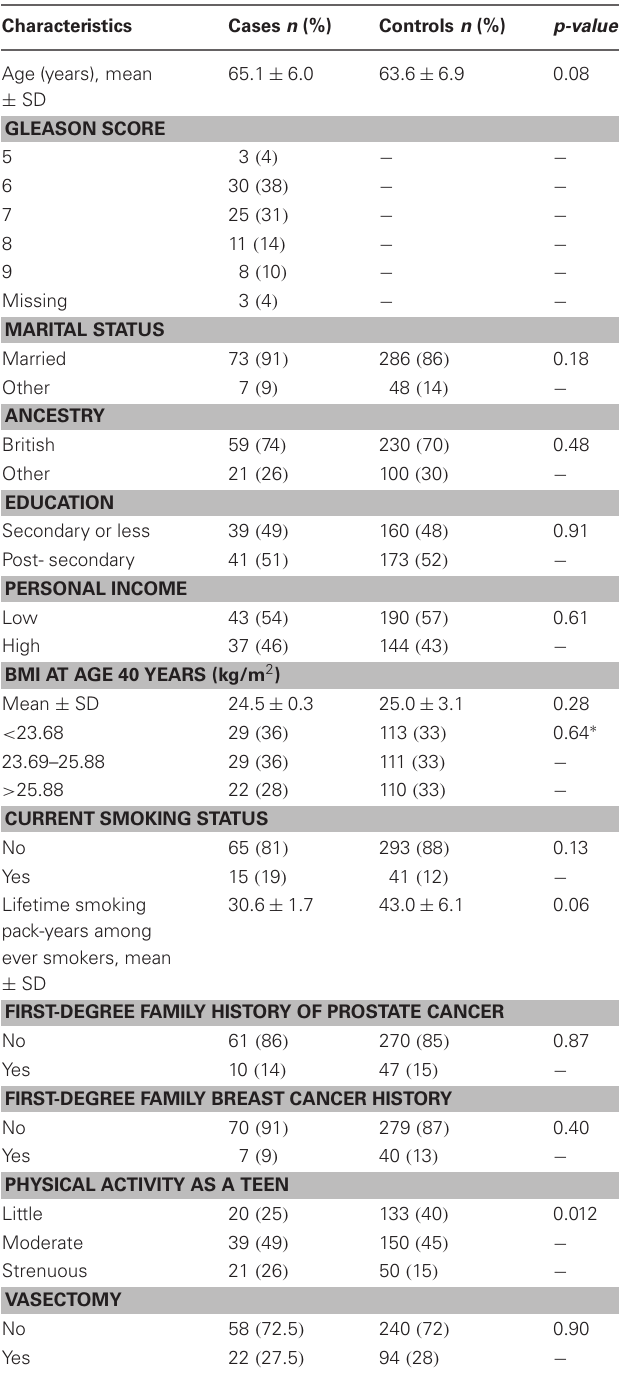
Table 1 | Characteristics of study participants, n = 414 (80 cases; 334